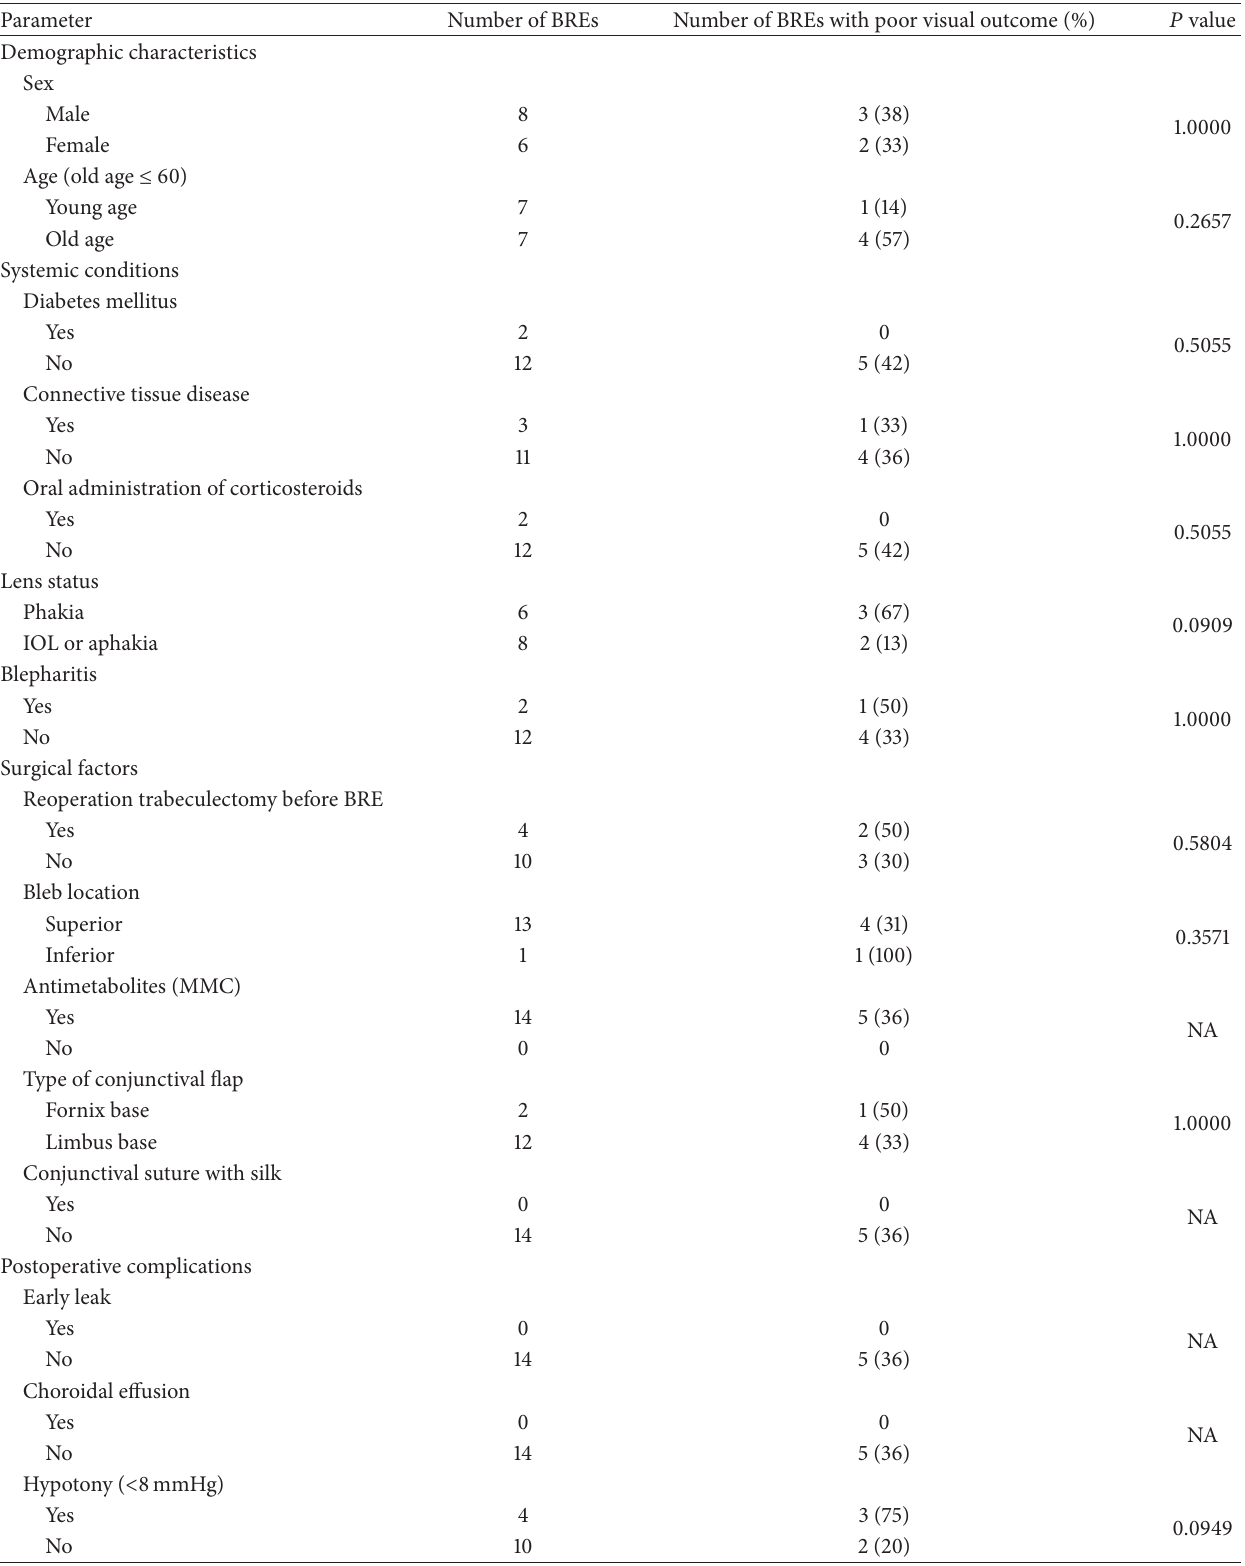
Table 4: Comparison factors between BREs with and without poor visual